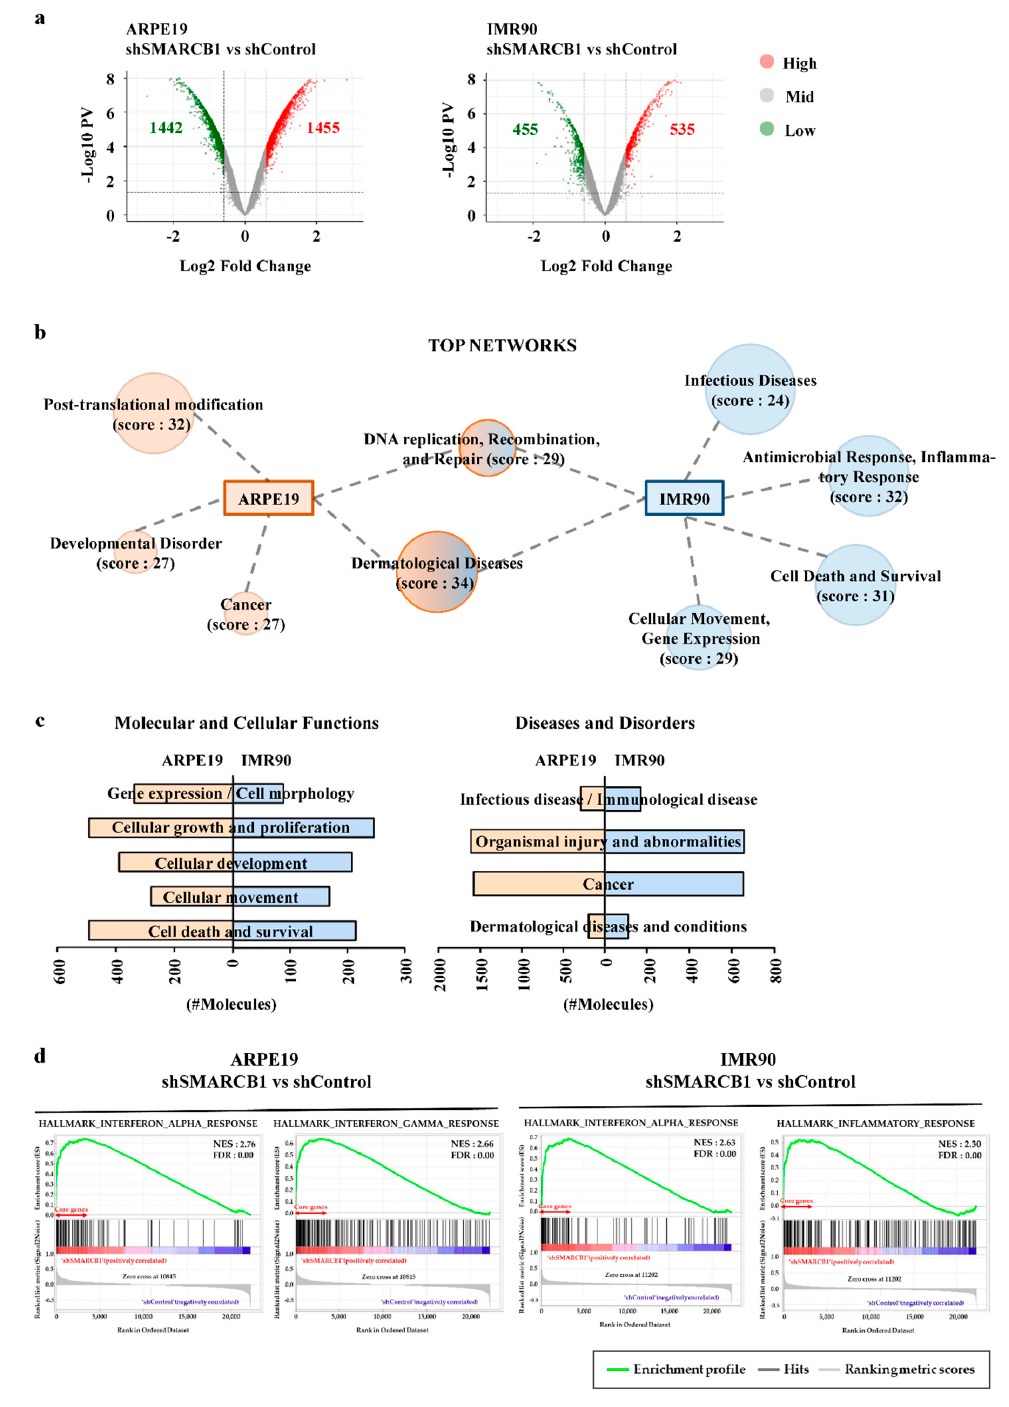
Figure 2. SMARCB1 modulates similar transcriptome in ARPE19 and IMR90. ( a ) The volcano plot of statistical significance against 1.5 fold change in ARPE19 and IMR90. ( b ) Highly ranked and common networks of SMARCB1 knockdown ARPE19 and IMR90 based on ingenuity pathway analysis (IPA). The score is based on a p -value calculation, which calculates the likelihood that the network-eligible molecules that are part of a network are found therein by random chance alone. ( c ) The most significant and common diseases and bio functions of SMARCB1 knockdown ARPE19 and IMR90. The number of molecules (genes) that are associated with each function. ( d ) Immune response-associated gene set enrichment analysis (GSEA) of SMARCB1 knockdown ARPE19 and